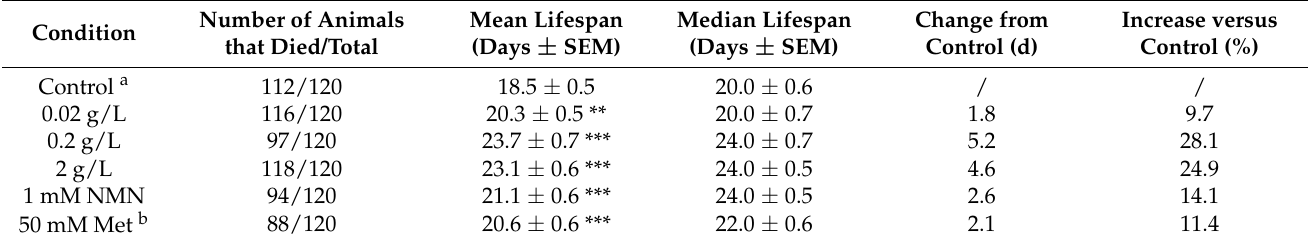
Table 1. Effect of QBLP supplementation on the